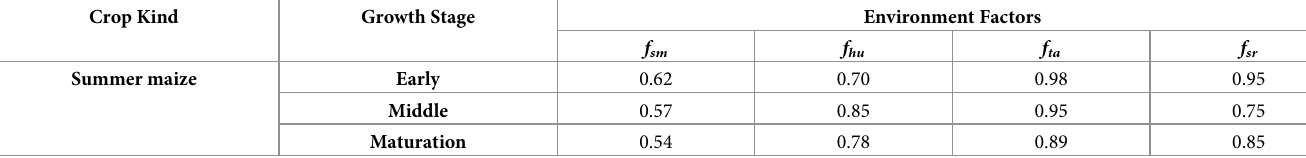
Table 5. Environmental factor values for summer maize during different periods.